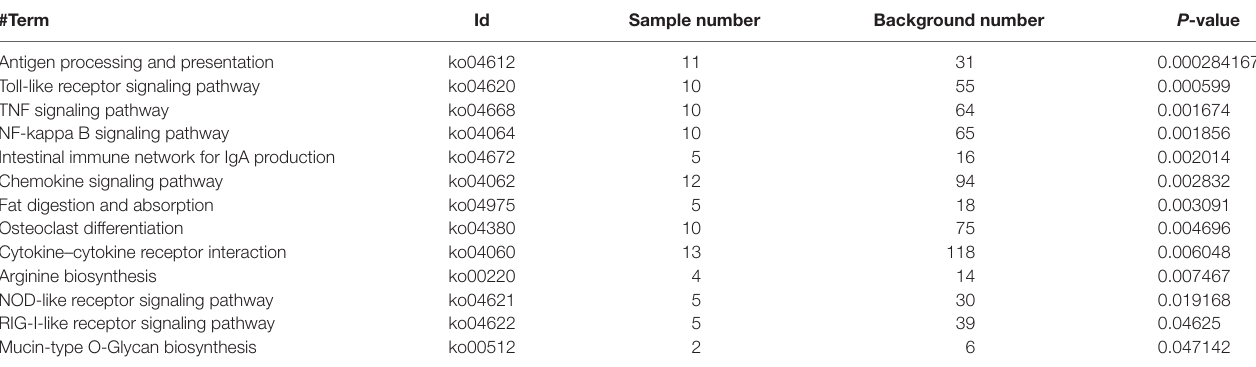
TaBle 2 | Enrichment analysis of the KEGG pathways for differentially expressed genes in WT vs RIP2 − / − zebrafish larvae. #Term id